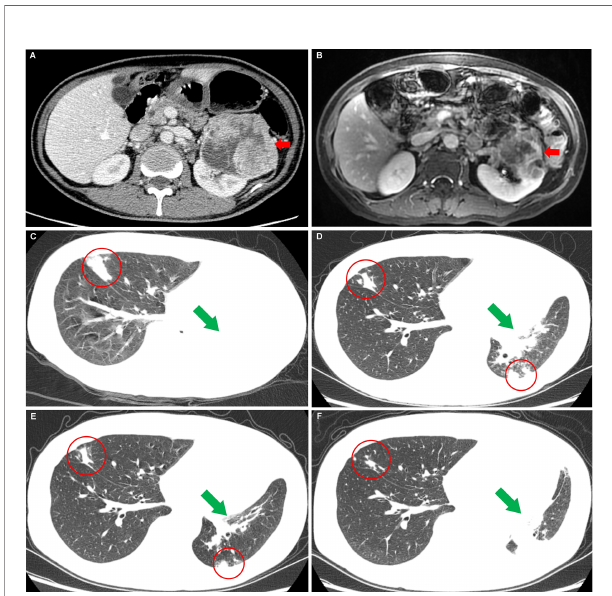
showed an enhancing mass measuring 9.3 cm × 8.2 cm × 7.7 cm (red arrow) in the left renal. (B) Magnetic resonance image examination revealed a signi fi cantly reduced mass [7.3 cm × 6.8 cm × 7.0 cm (red arrow)] in the left renal after sorafenib-targeted therapy for 14 months. (C) Before nilapanib; (D) After nilapanib for 2 months; (E) After nilapanib for 4 months; (F) After nilapanib for 5 months. Chest CT showed metastases in the lungs (red circle) and atelectasis in the left lung (green arrows) due to the tumor invasion of the left bronchus, received continuous remission in the fi rst 4 months after